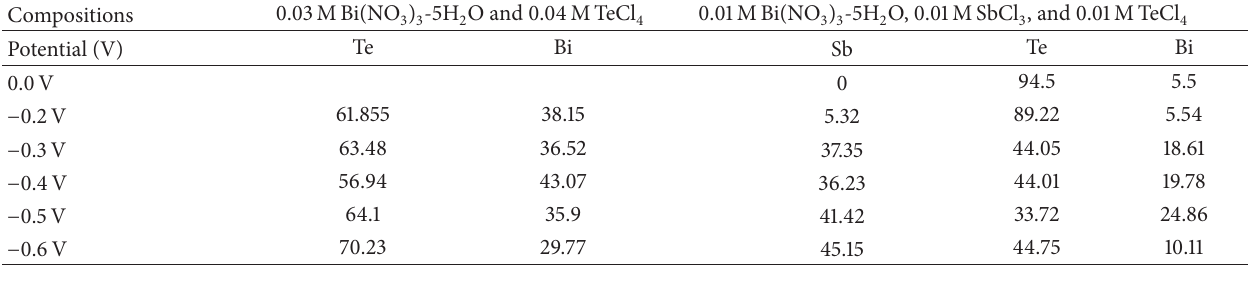
, and 0.01MTeCl 3